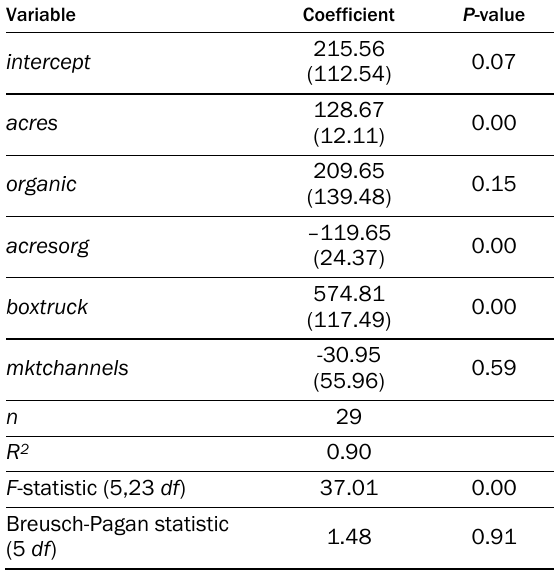
Table 4. Results for Truckload Weight